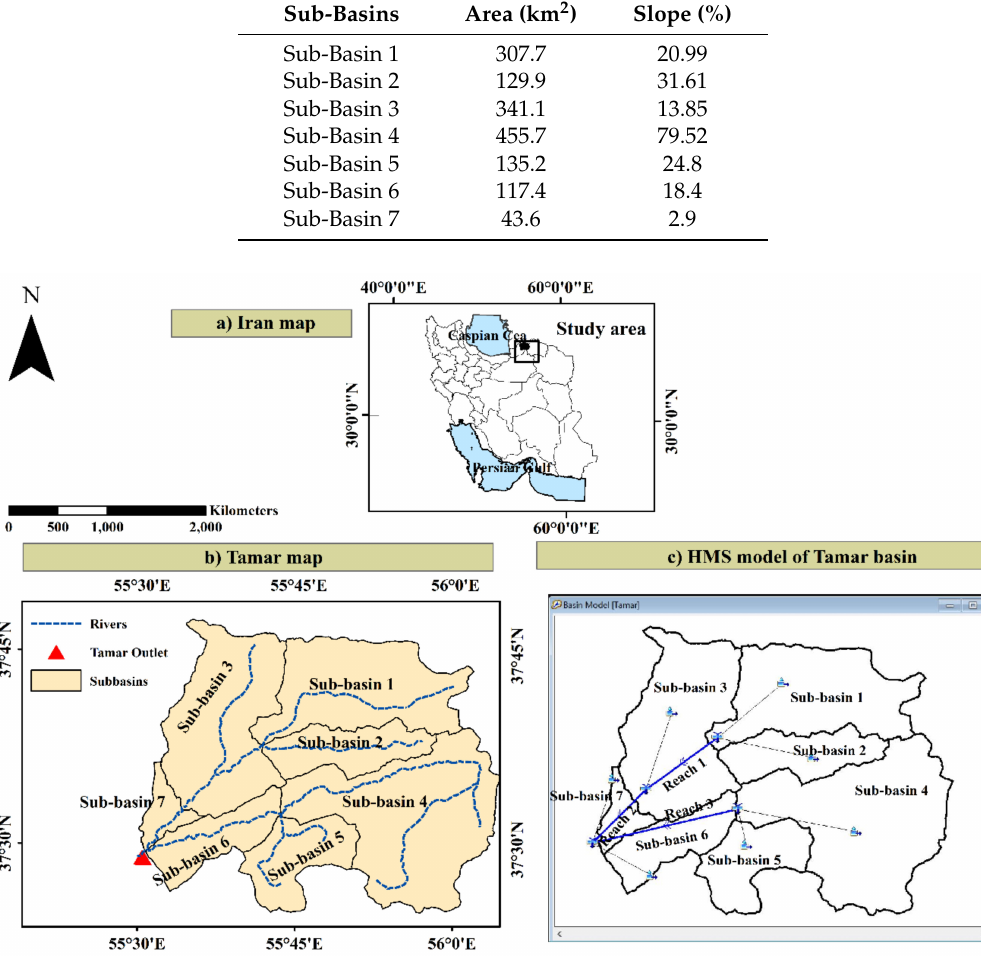
Figure 2. Geographical location of the Tamar basin on Iran’s map and its representation in